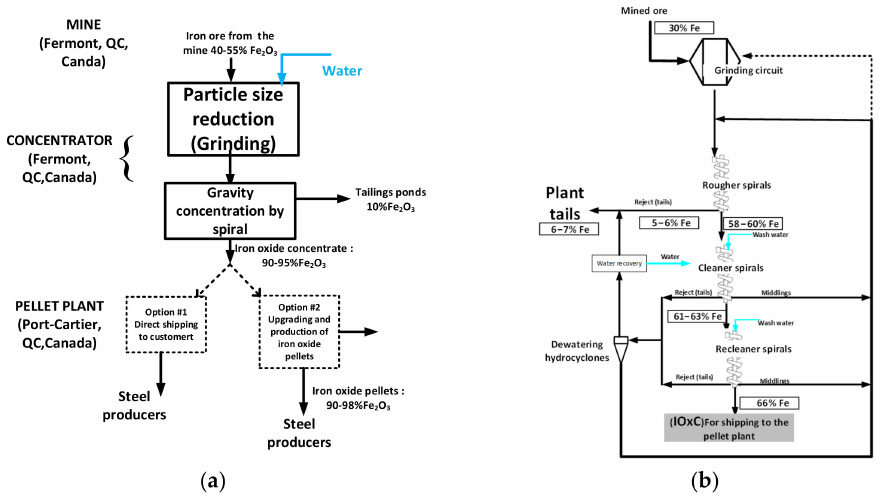
Figure A1. ArcelorMittal mine, concentrator and pellet plants. ( a ) Iron ore processing from ore to the iron oxide products; Mine, concentrator and pellet plants. ( b ) Concentrator at the mine site; Production of the IOxC (mine and